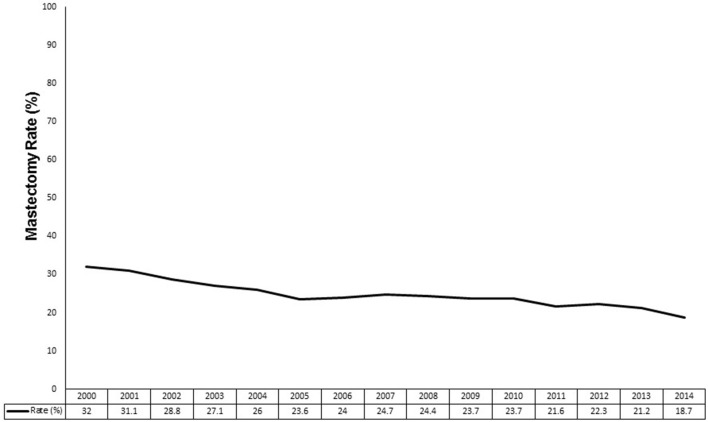
Mastectomy rates by year from 2000 to 2014.